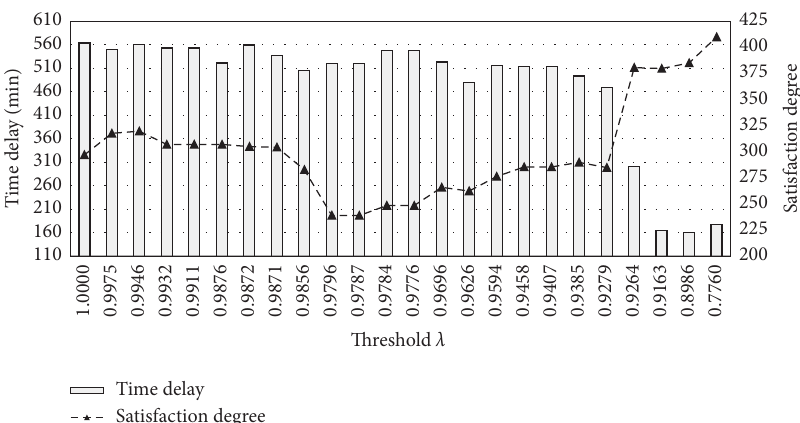
Figure 14: The adequate solutions of M.1 under each clustering